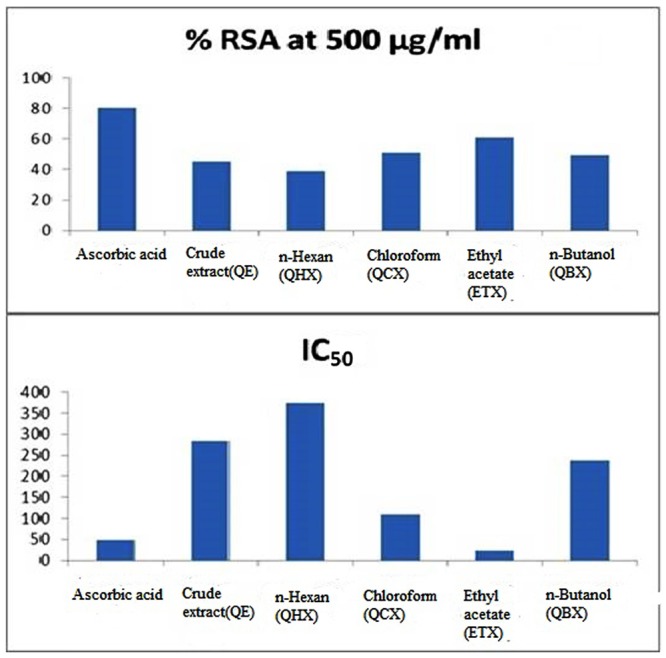
NO activity in % RSA and IC50 values.